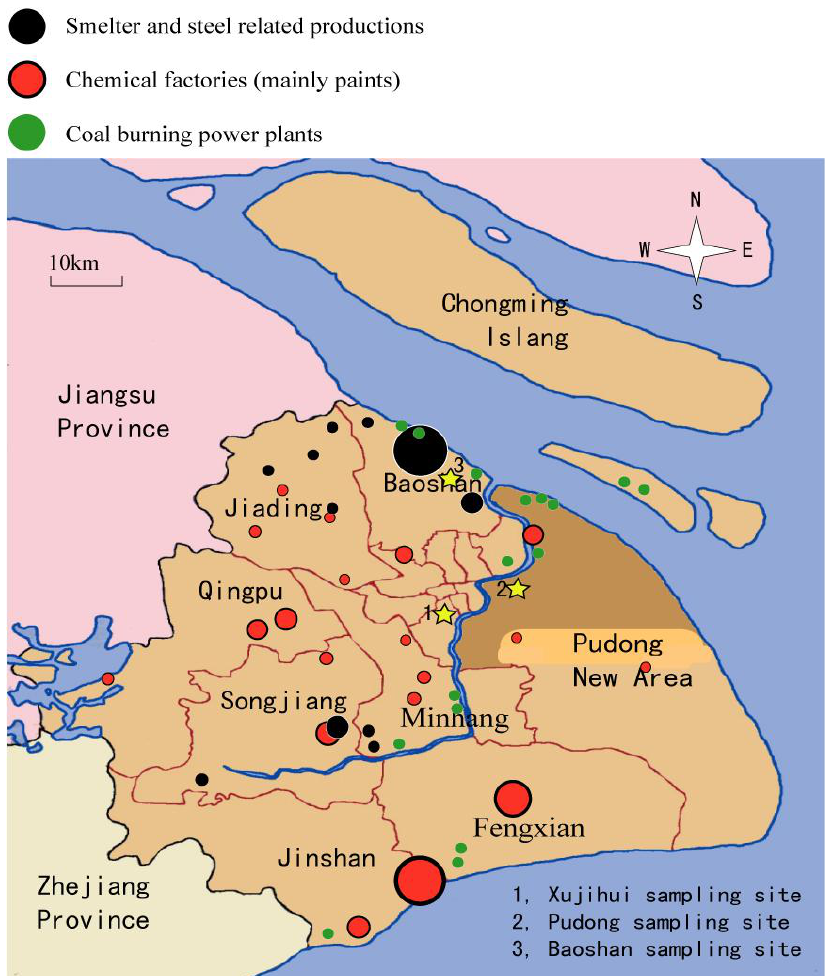
Figure 3. Locations of the sampling sites (stars) and the possible pollutant sources in Shanghai (different colors indicate different pollutant